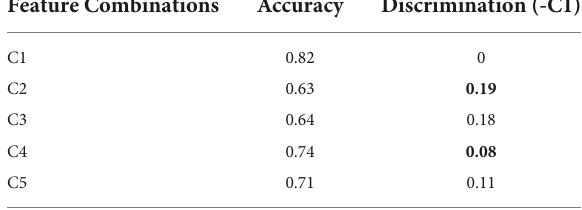
TABLE 8 Classification results with different feature combinations for Exercise